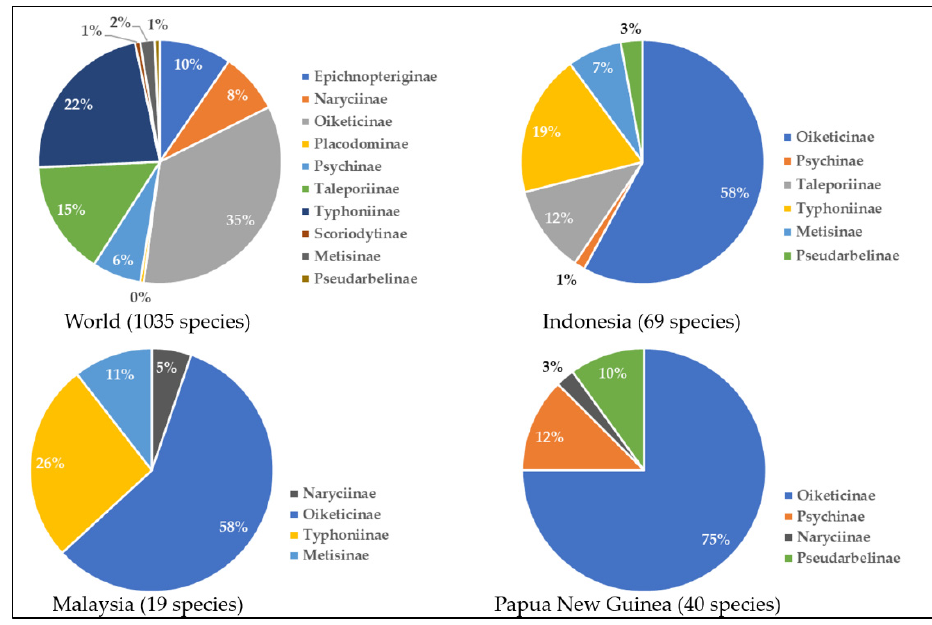
Figure 1. Proportion of number of species in different subfamilies of Psychidae in Indonesia and neighboring countries (Malaysia and Papua New Guinea) and at global level. These two countries are directly adjacent to Indonesia: Malaysia to the west of Indonesia and Papua New Guinea to the east of Indonesia. Data sources [9,17,25,34–37].